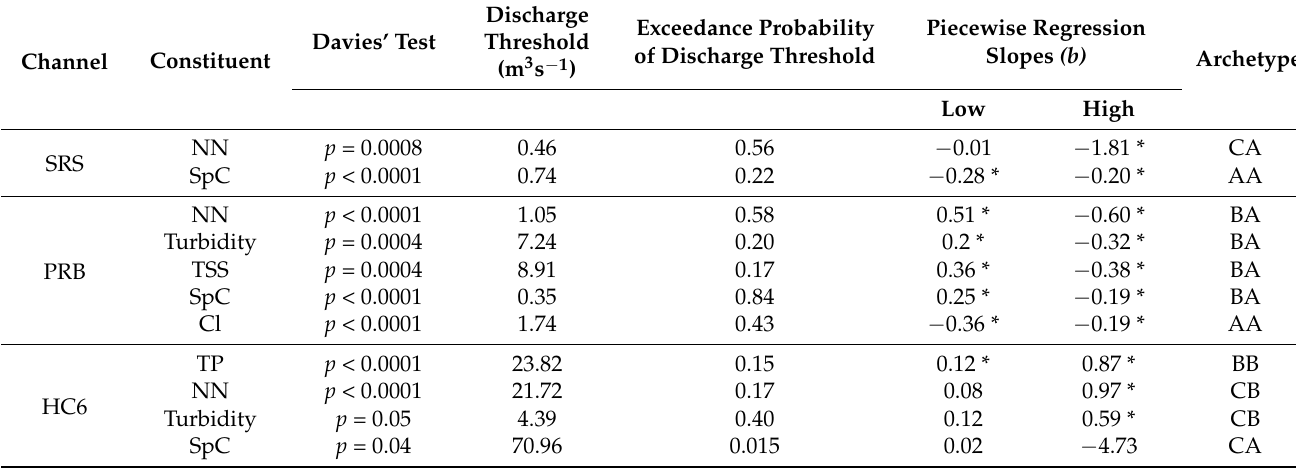
Table 4. Piecewise (segmented) linear regression slopes ( b ) for water quality constituents that have statistically significant inflections in b (discharge thresholds) according to the Davies’ test for the different